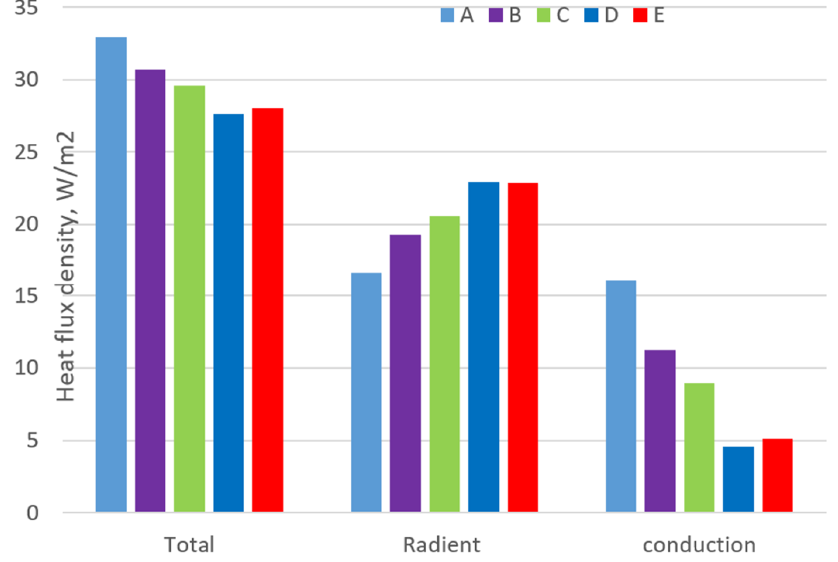
Figure 8. Dry heat loss of the different sizes of garments.